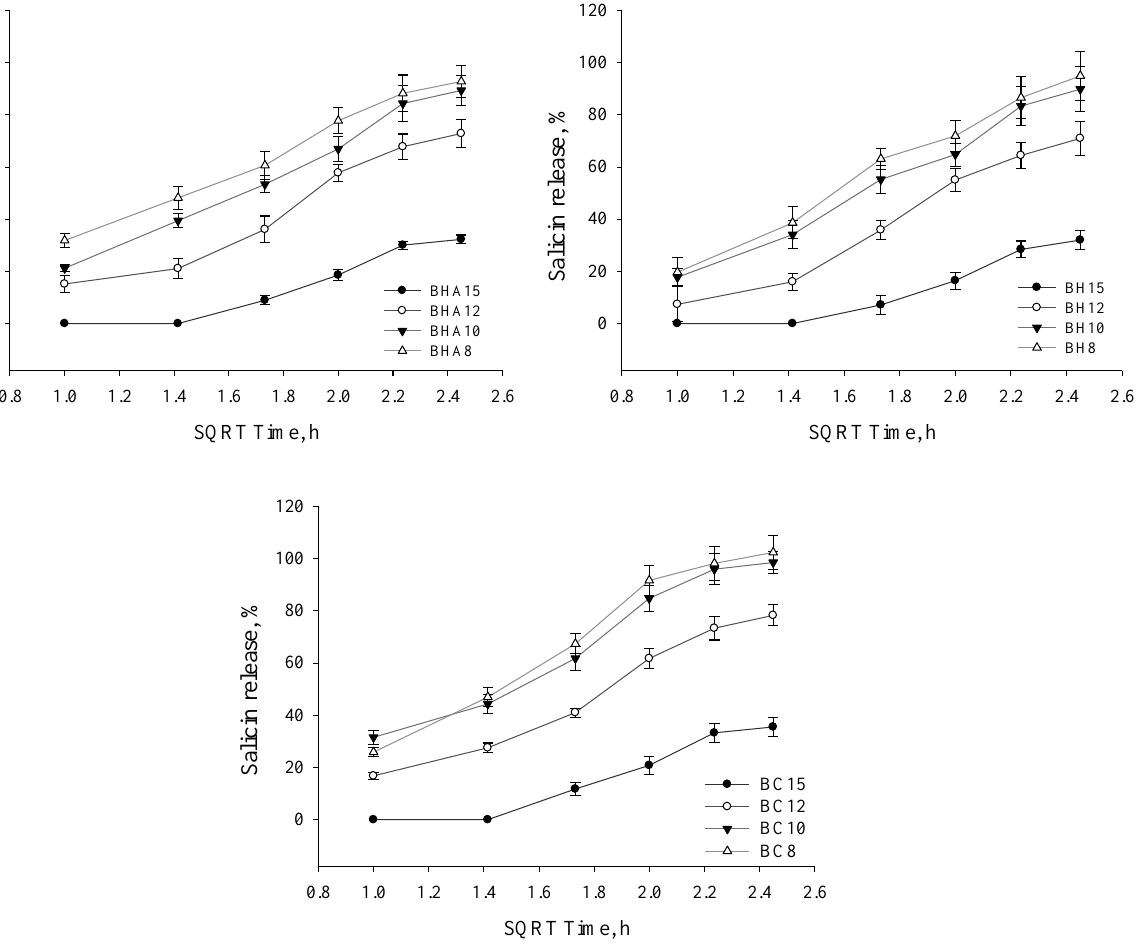
Figure 6. Percentage release of salicin verses square root of time from all tested ophthalmic formu- lations (mean ± SD, n = 3).